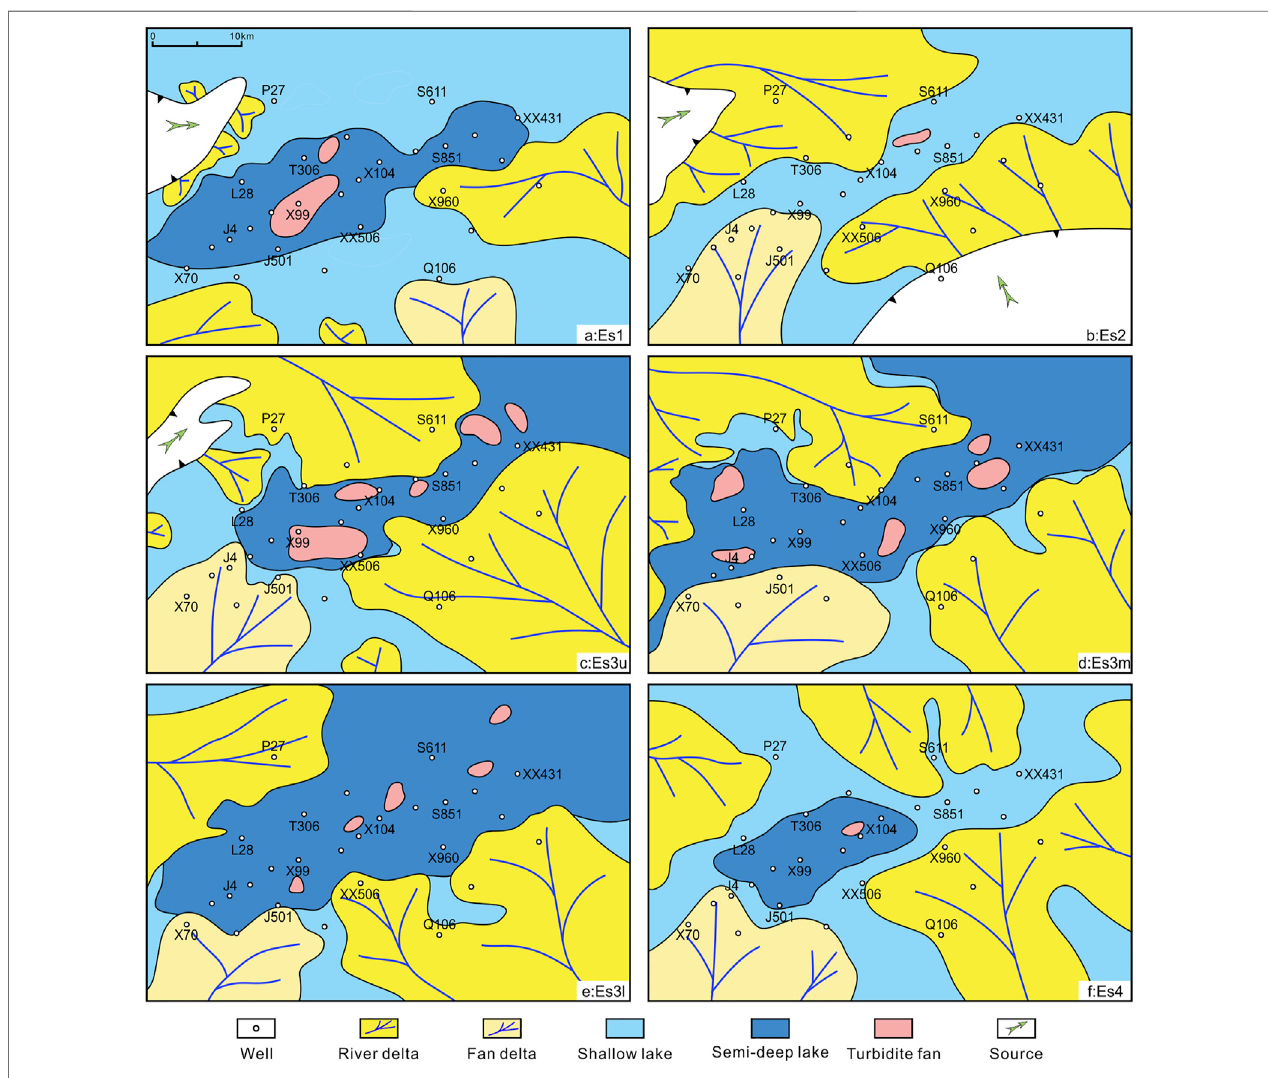
FIGURE 4 | Representative sedimentary facies distribution of different formations in the Linnan Sag (modi fi ed from Chang, 2007; Liu, 2015; Lin et al., 2016; Cao et al., 2017). The lithologies have been assigned according to the different sedimentary facies.